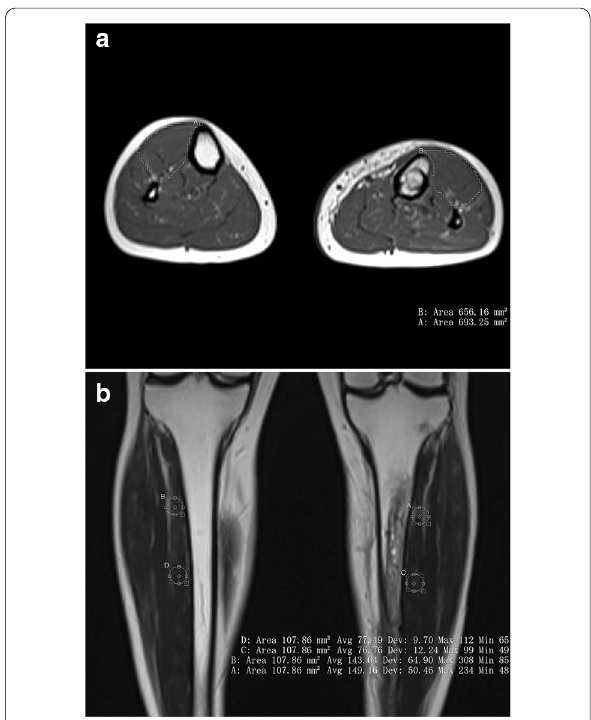
limb was calculated to evaluate the recovery of skeletal muscle volume. b T2-weighted image obtained in the coronal plane.